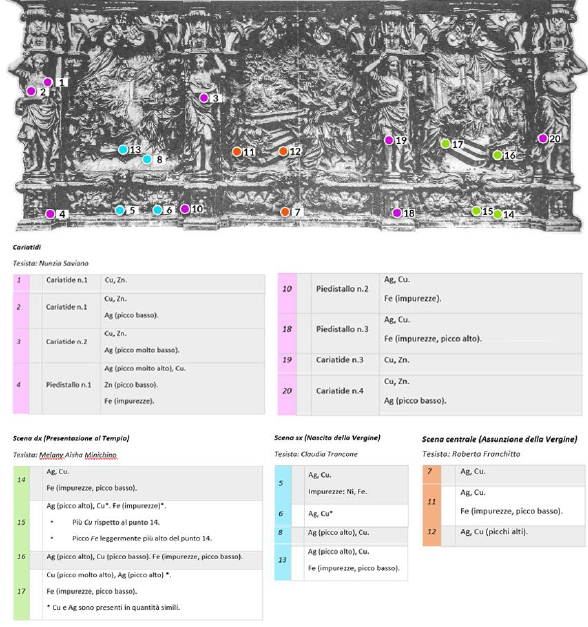
Figure 11 . X-ray fluorescence (XRF): detected points mapping. All the textured photogrammetric mesh of the frontal